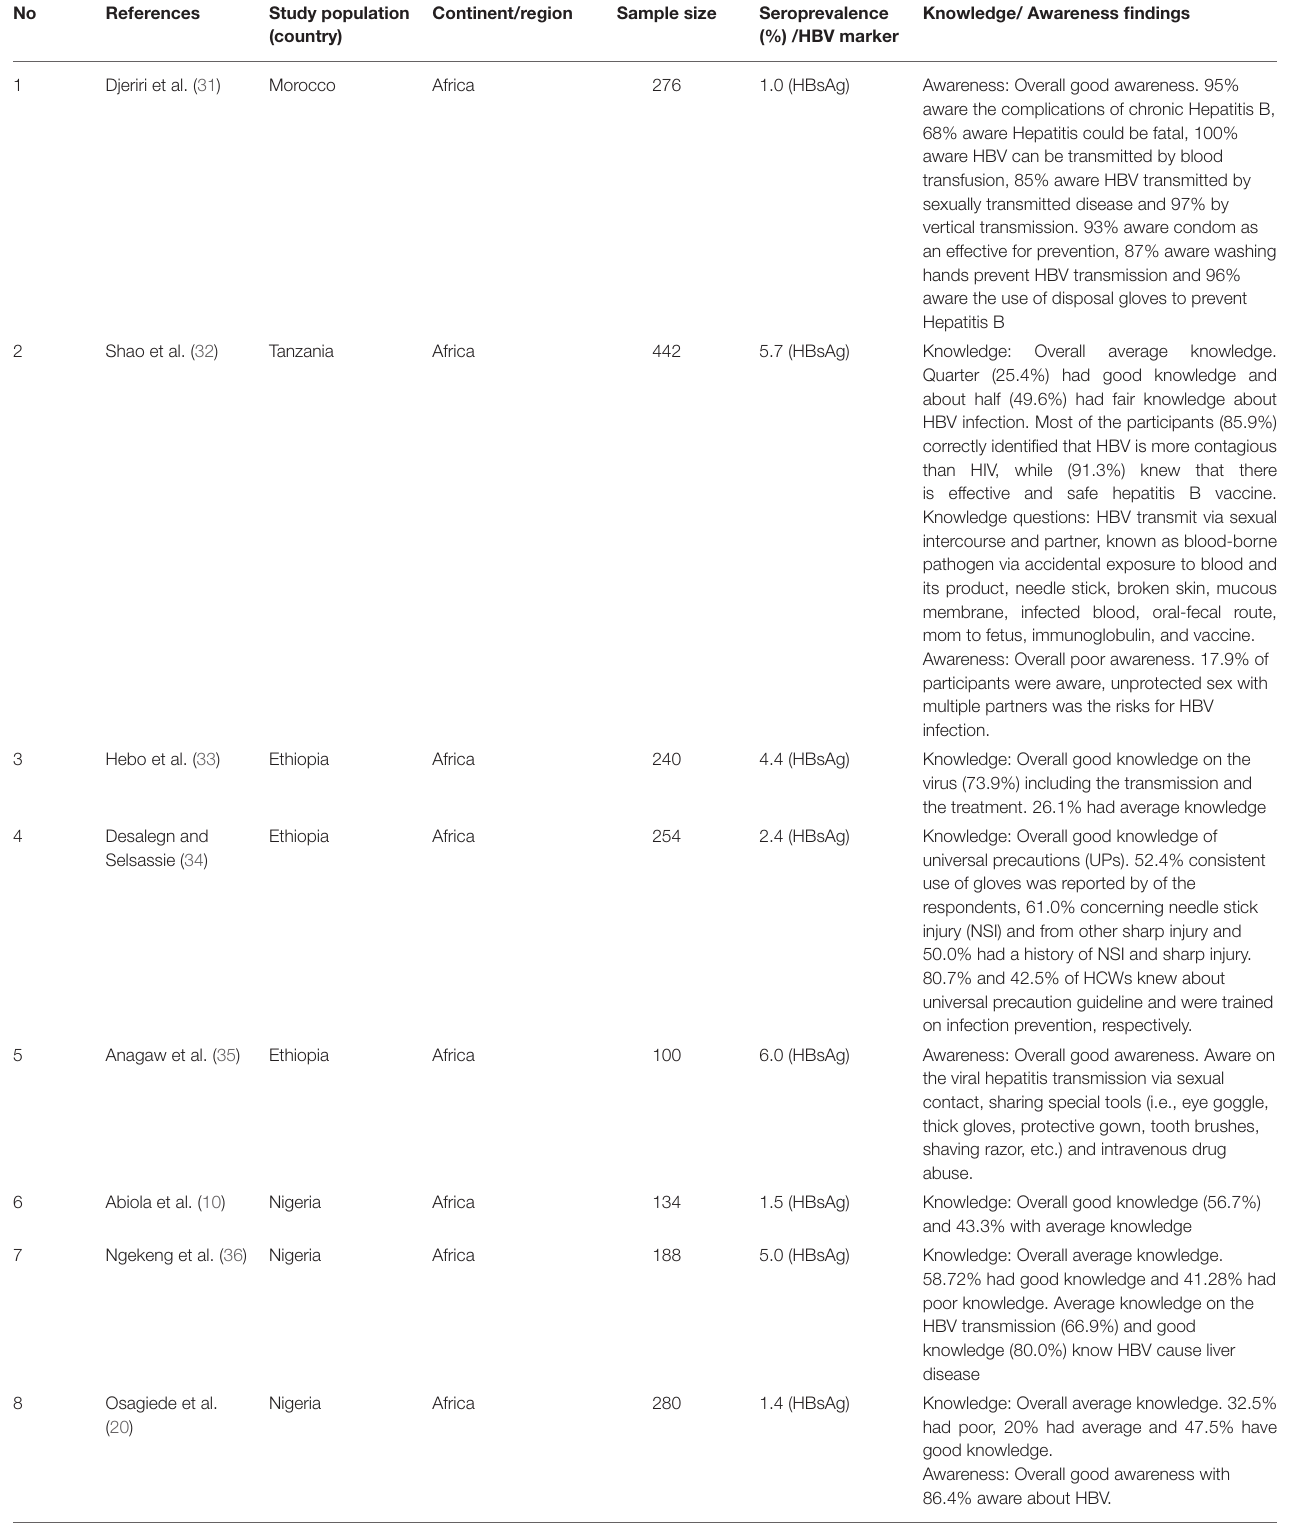
TABLE 1 | List of included